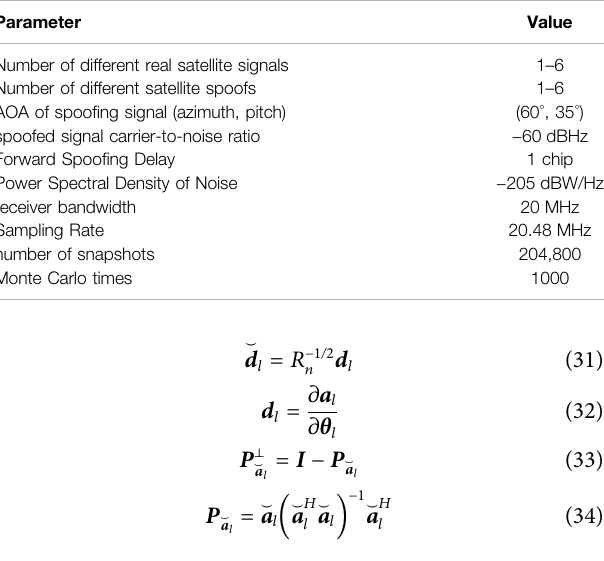
TABLE 1 | Simulation parameter